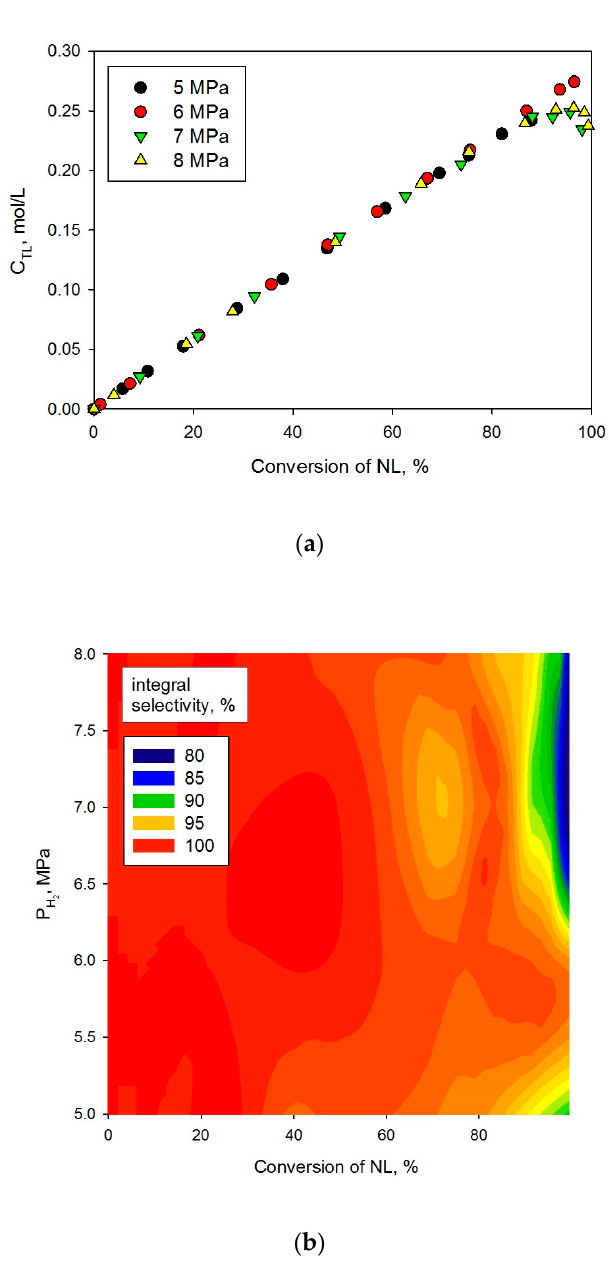
Figure 5. Dependence of TL accumulation on the conversion of NL at variation of the overall pressure ( a ) and diagram of integral selectivity with respect to TL as a function of both NL conversion and pressure ( b ) (1.5 g of NL, 0.1 g of catalyst, 40 mL of hexane, 250 °C).